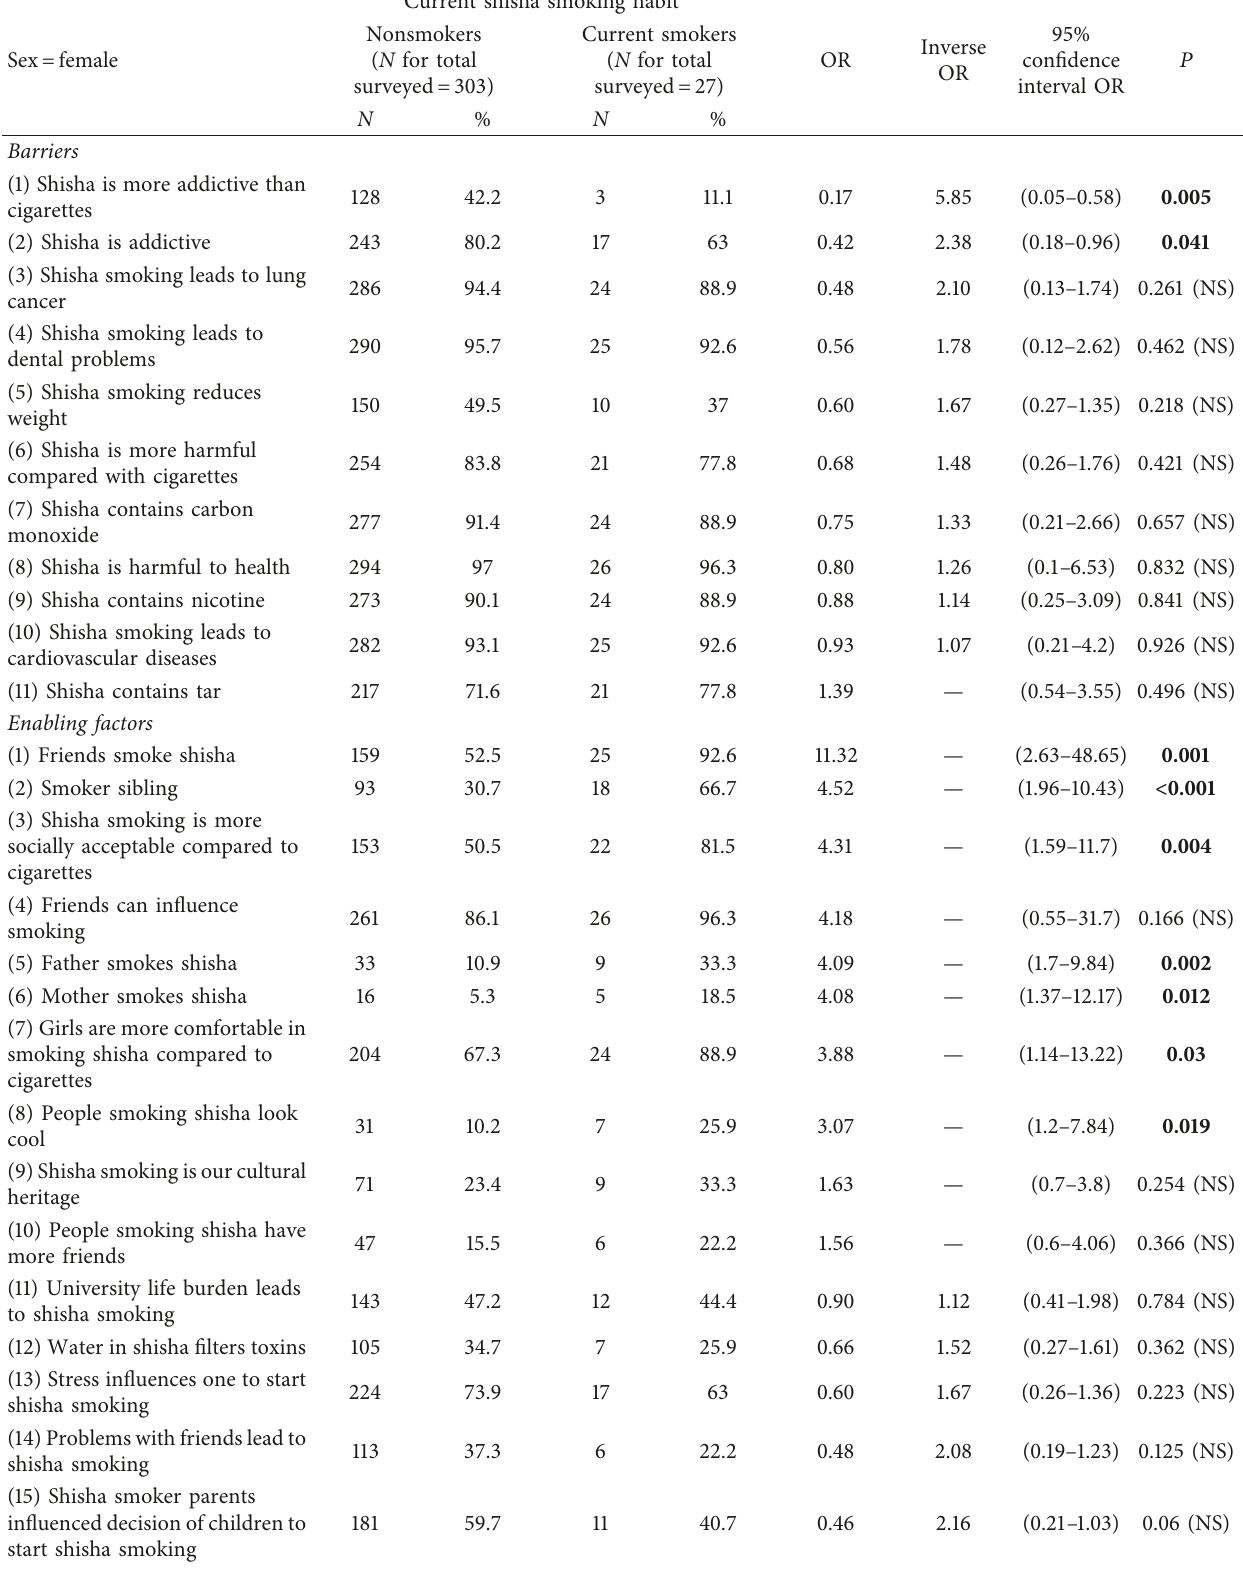
Table 9: The strength of association between selected barriers and enabling factors with current shisha smoking habits among